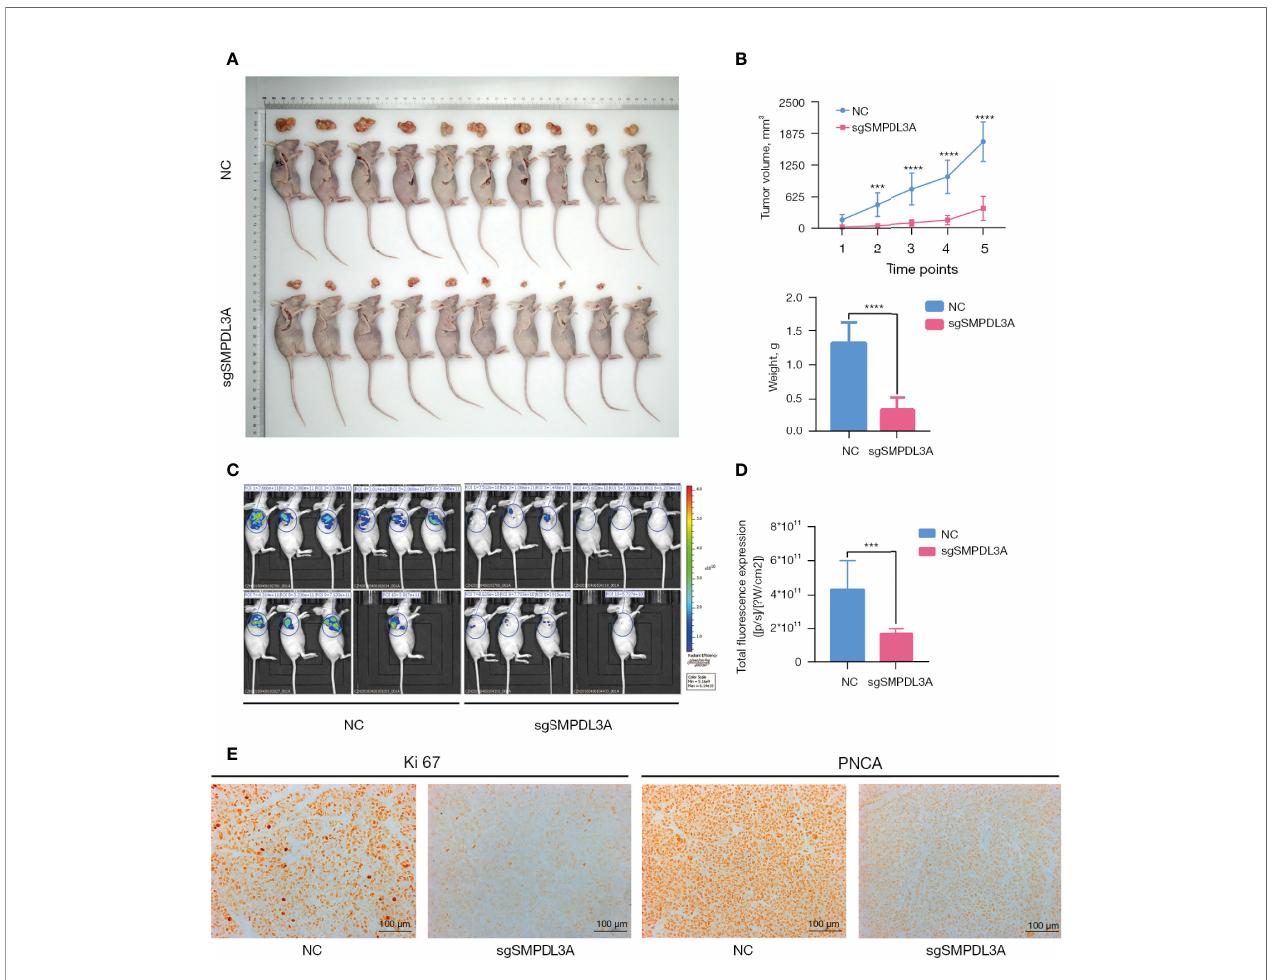
FIGURE 7 | The effect of SMPLD3A on subcutaneous tumor formation in a nude mouse xenograft model of liver cancer. (A) Representative images of tumors in the SMPDL3A knockout and the control groups. (B) sgSMPDL3A led to a signi fi cant decrease in tumor volume and weight, compared with control group (****P=0.0001). (C) Fluorescence images of each group in nude mice subcutaneous tumor. (D) Fluorescence intensity of two groups of nude mice subcutaneously implanted tumors (***P=0.001). (E) Representative images of Ki67 and PNCA staining of subcutaneous tumors in each